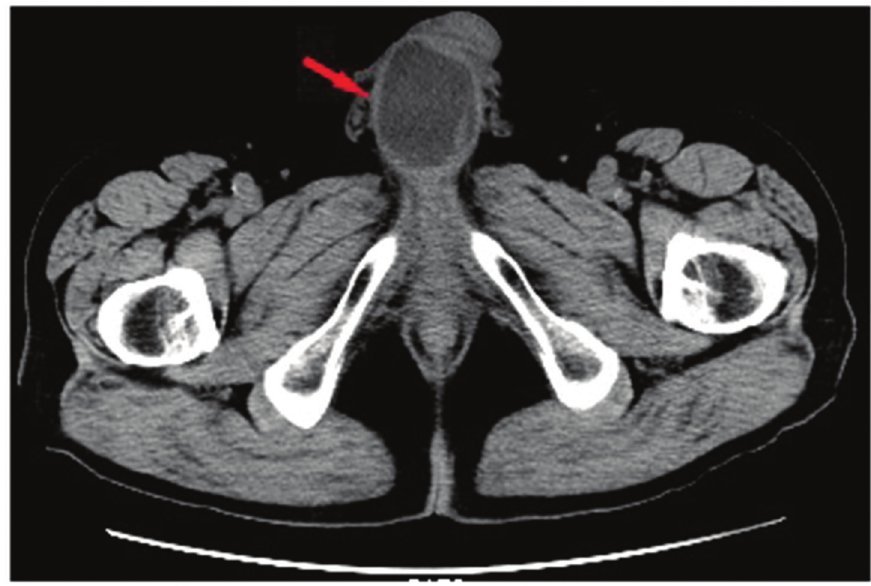
Figure 1. CT scan of a mass of 4.9 × 3.5 cm found in the cavernous body of the penis